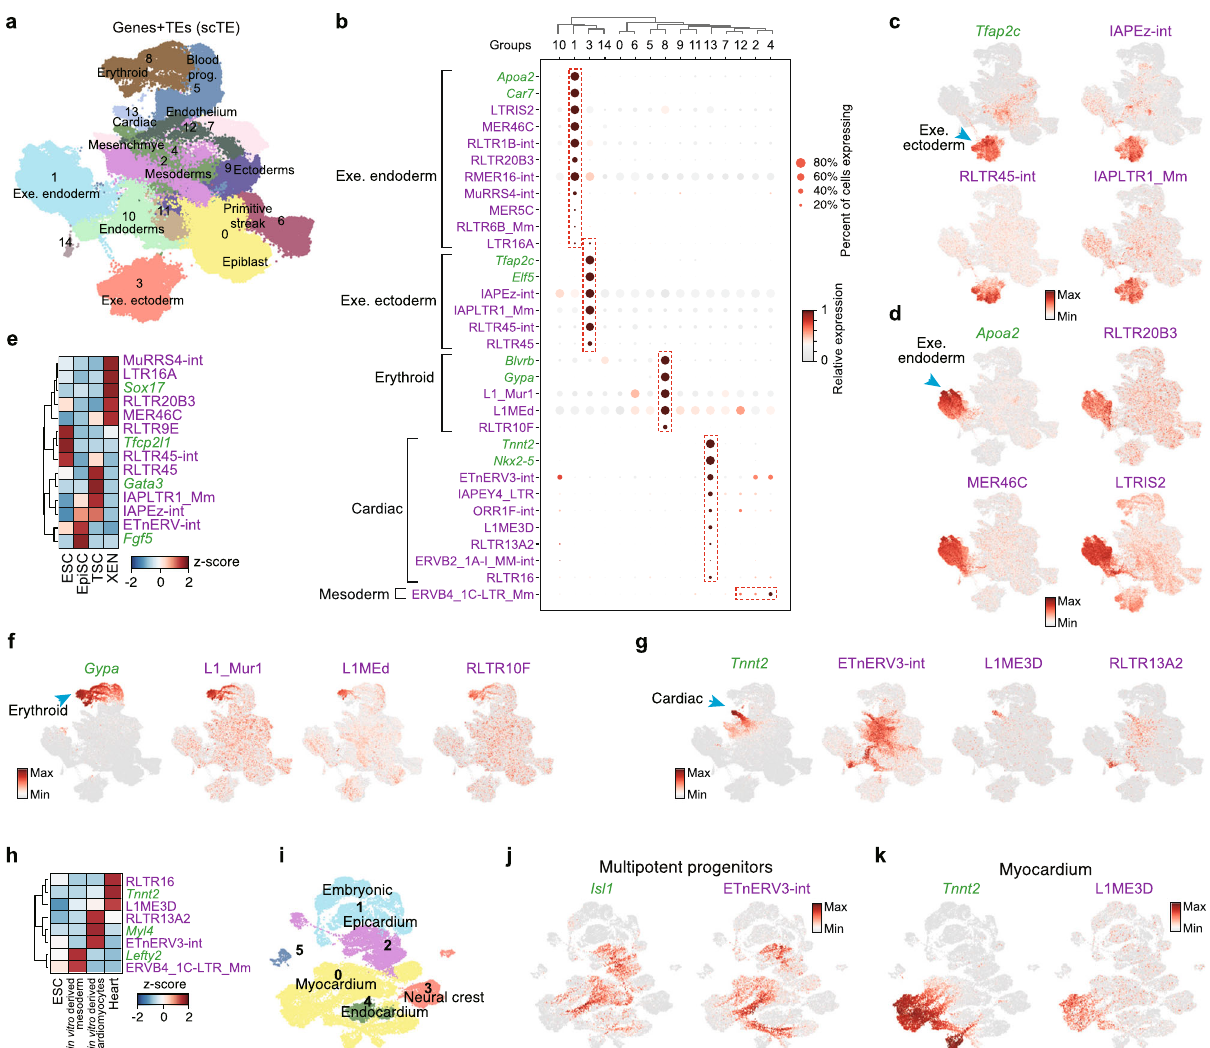
Fig. 3 Widespread cell type-speci fi c expression of TEs during gastrulation. a UMAP plots of the mouse gastrulation data using both genes and TEs. Selected lineages are labeled (Leiden, resolution = 0.3). b Dot plot showing a selection of marker genes and TEs for the indicated cell lineages. c Expression of the indicated extra embryonic ectoderm gene Tfap2c and selected TEs. d Expression of the extra embryonic endoderm marker gene Apoa2 and selected TEs. e Expression of the indicated TEs and marker genes in bulk RNA-seq data from ESCs, EpiSCs, XEN (extra embryonic endoderm cells) and TSCs (trophoblast stem cells). Tfcp2l1 , Fgf5 , Gata3 , and Sox17 serve as markers for ESCs, EpiSCs, TSCs, and XEN cells, respectively. Data are displayed as a z - score using the variance from all genes. f Expression of the erythroid marker gene Gypa , and selected TEs. g Expression of the cardiac marker gene Tnnt2 and selected TEs. h Expression of the indicated TEs and marker genes from bulk RNA-seq data. i UMAP plot of the embryonic mouse heart scRNA-seq data using both TEs and genes. The indicated developmental stages are labeled as in the original study. j , k UMAP as ( i ), but cells are colored by the expression of indicated